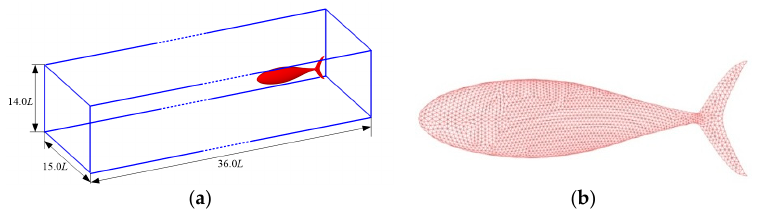
Figure 7. Computational domain and grids of the thunniform bio-inspired mode: ( a ) computational domain; ( b ) grids.